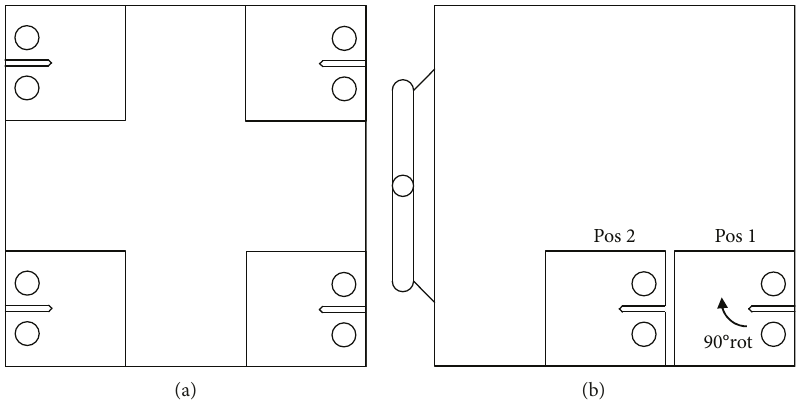
Figure 5: Alignment of the CT specimens on the compression-molded plates (a) and on the injection-molded plates (b). F Table 5: Load levels used for the fatigue fracture tests ( F max , min are the maximum and minimum load of the sinusoidal signal, respectively). Data